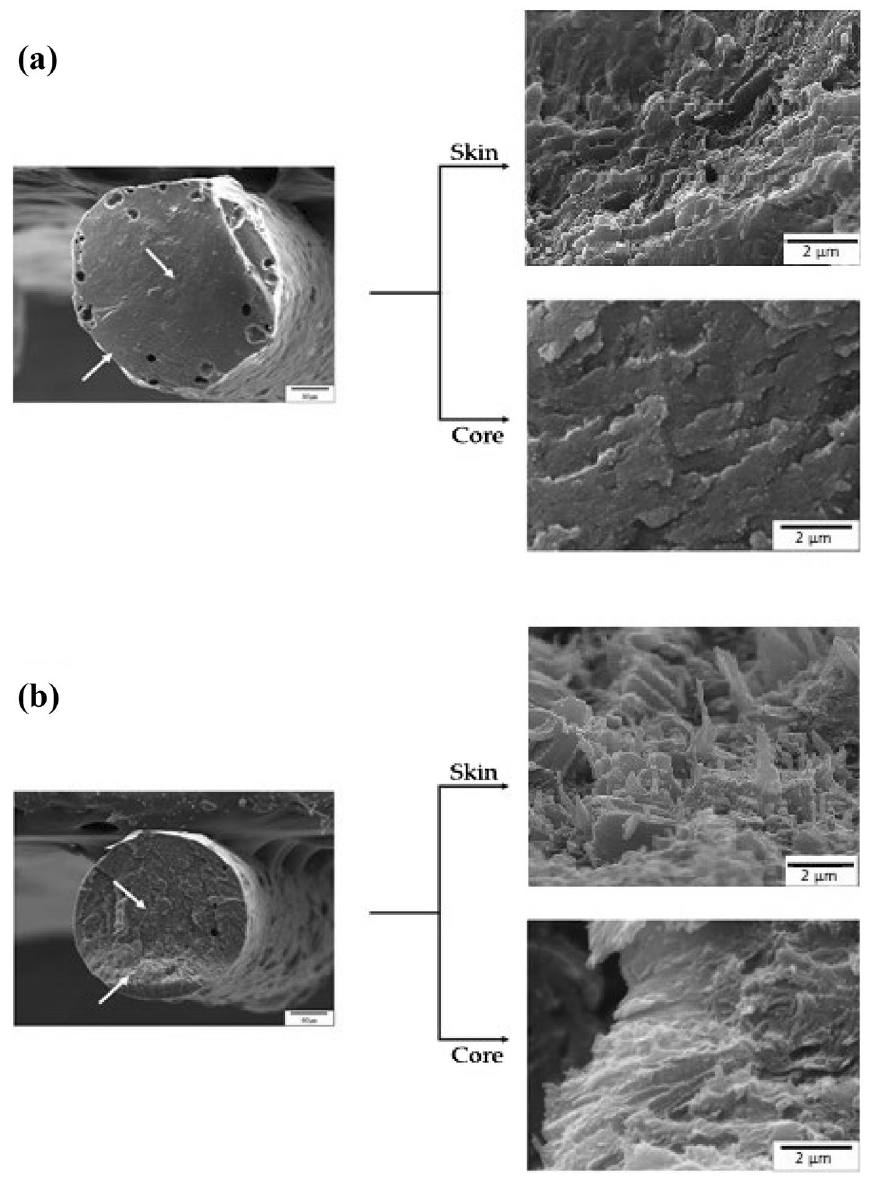
Figure 7. SEM images of the skin–core morphology in the ( a ) as-spun and ( b ) 240/9